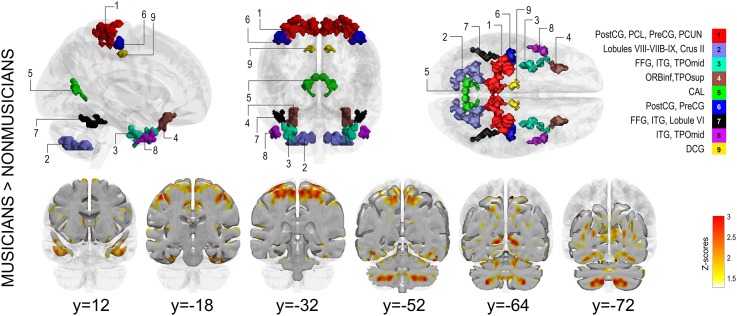
Symmetry maps showing significantly greater functional symmetry for musicians compared to nonmusicians.Top of figure: Orthogonal planes (lateral, frontal, transversal) showing significant clusters (voxelwise thresholded at p < 0.01 [z = 2.32]; cluster-wise corrected at p < 0.001). Bottom of figure: Coronal slices showing the continuous Z-map for the respective comparison. Abbreviations: PostCG = postcentral gyrus, PCL = paracentral lobule, PreCG = precentral gyrus, PCUN = precuneus, FFG = fusiform gyrus, ITG = inferior temporal gyrus, TPOmid = temporal pole (middle temporal gyrus), ORBinf = orbitofrontal cortex (inferior frontal gyrus), TPOsup = temporal pole (superior temporal gyrus), CAL = calcarine fissure and surrounding cortex, DCG = median cingulate and paracingulate gyrus.